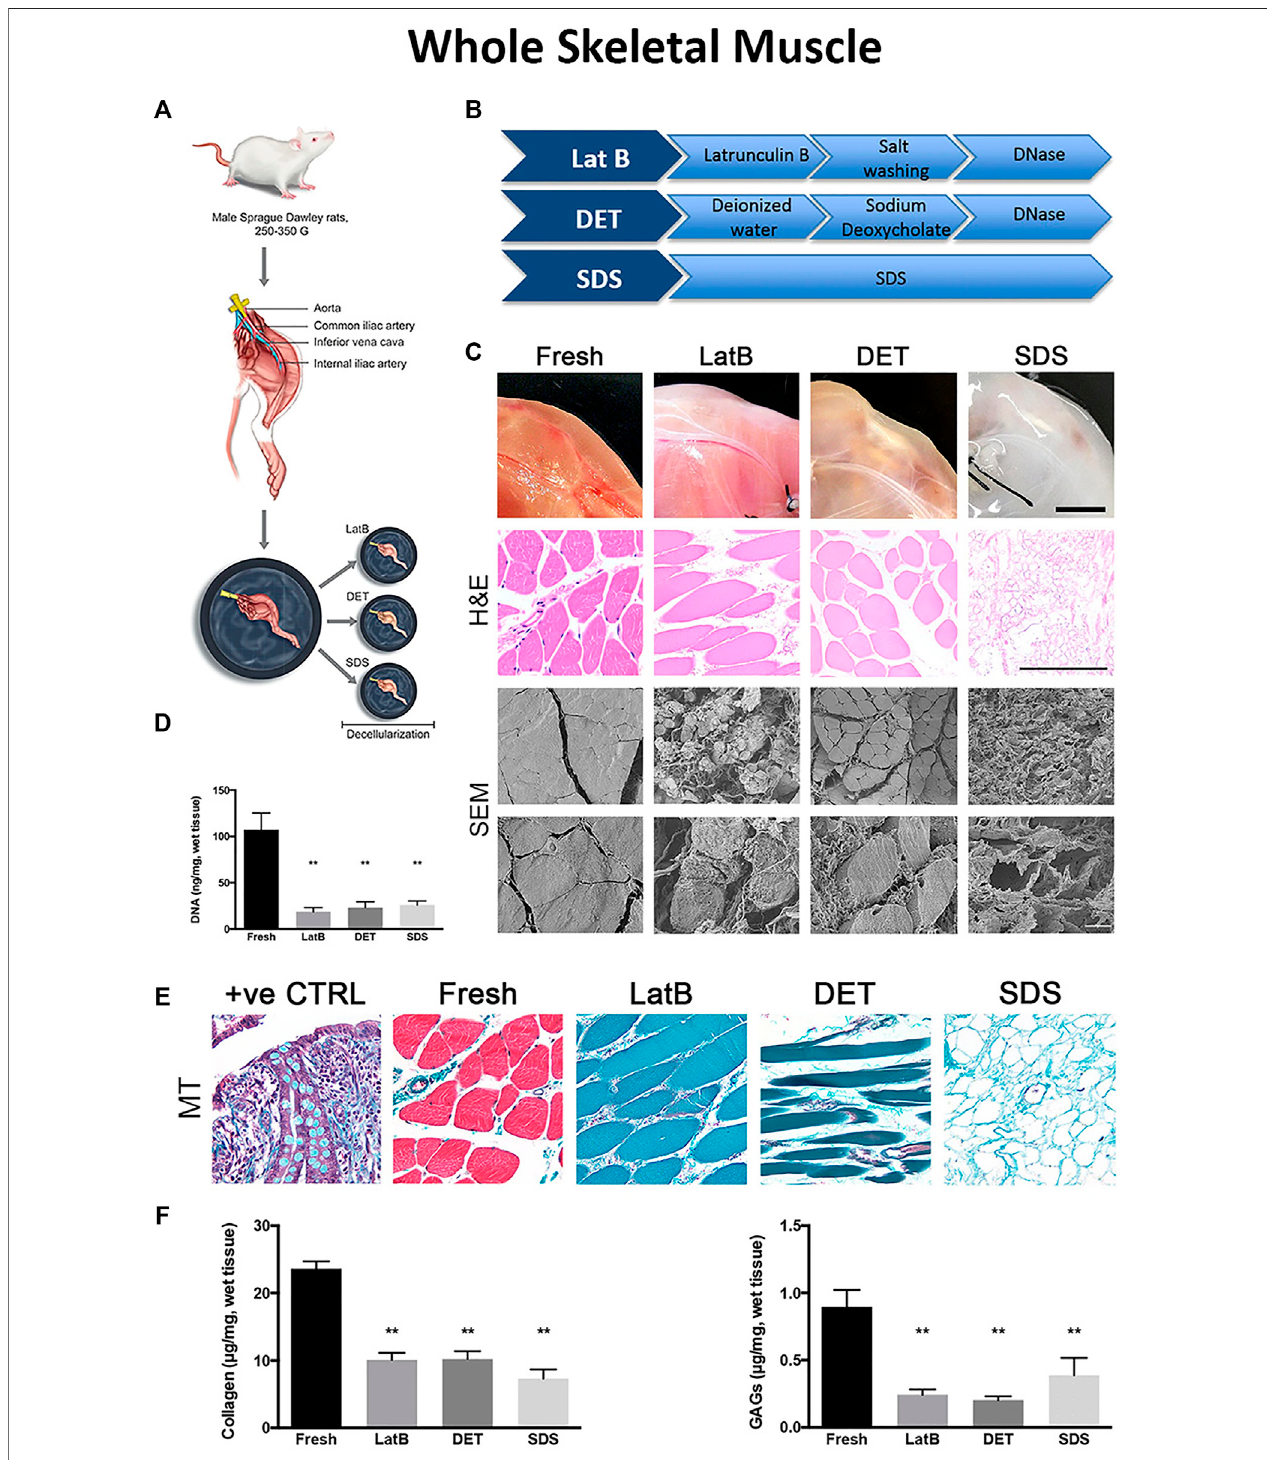
FIGURE 4 | Differences in decellularization protocols determine dECM properties in whole tissues (A) Schematic of tissue harvest from a rat hindlimb for whole muscle decellularization (B) A breakdown of three example decellularization protocols used in whole tissue decellularization (C) Final DNA content after whole tissue decellularization using three different decellularization protocols (D) Tissue morphology from top to bottom: Macroscopic tissue images, Hematoxylin and Eosin (H&E) staining, and Scanning Election Microscope (SEM) images of whole tissues before (Fresh, fi rst column) and after decellularization with LatB (second column), DET (third column), and SDS (fourth column) protocols (E) Massons Trichrome (MT) staining of whole tissue after decellularization (F) ECM content of collagen and GAGs remainingindecellularizedwholetissuescomparedtofreshtissues.FiguresA – Fareadapted from “ Decellularised skeletal musclesallowfunctionalmuscleregeneration by promoting host cell migration ” by Urciuolo et al. (2018) licensed under CC BY 4.0.